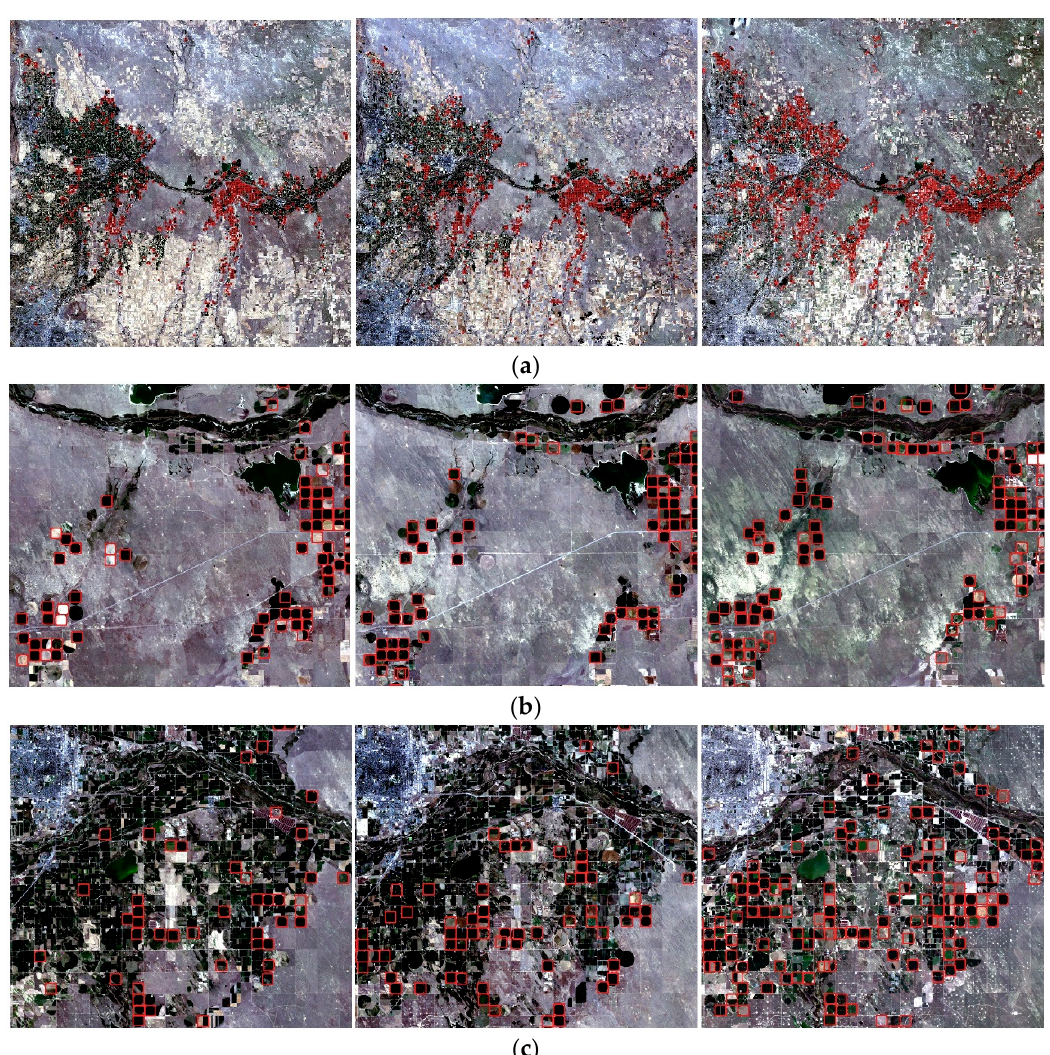
Figure 14. Results of using the same classification model for CPISs detection across different years. ( a ) Overview images. ( b ) Zoomed in images. ( c ) Zoomed in images. Images from left to right were collected from 1986, 2000, and 2011.